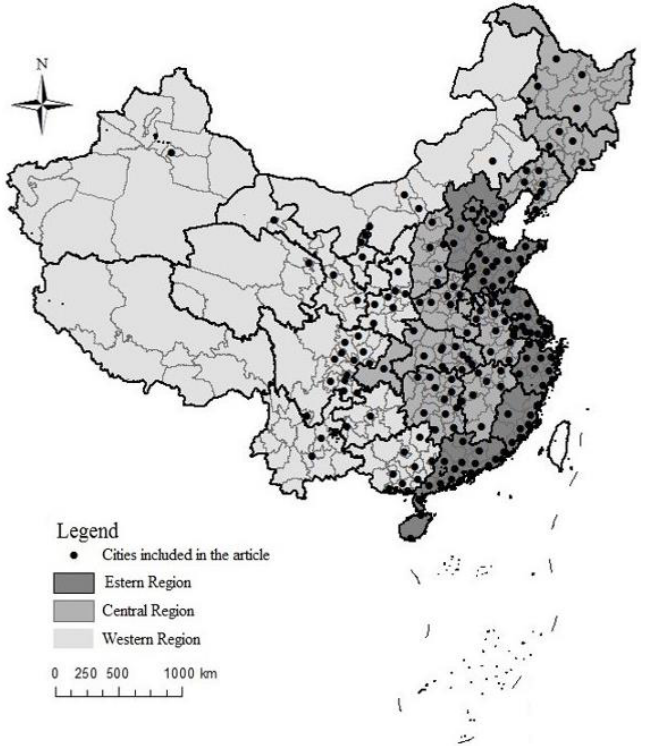
Figure 1. Map of 169 expanding cities included in the article.